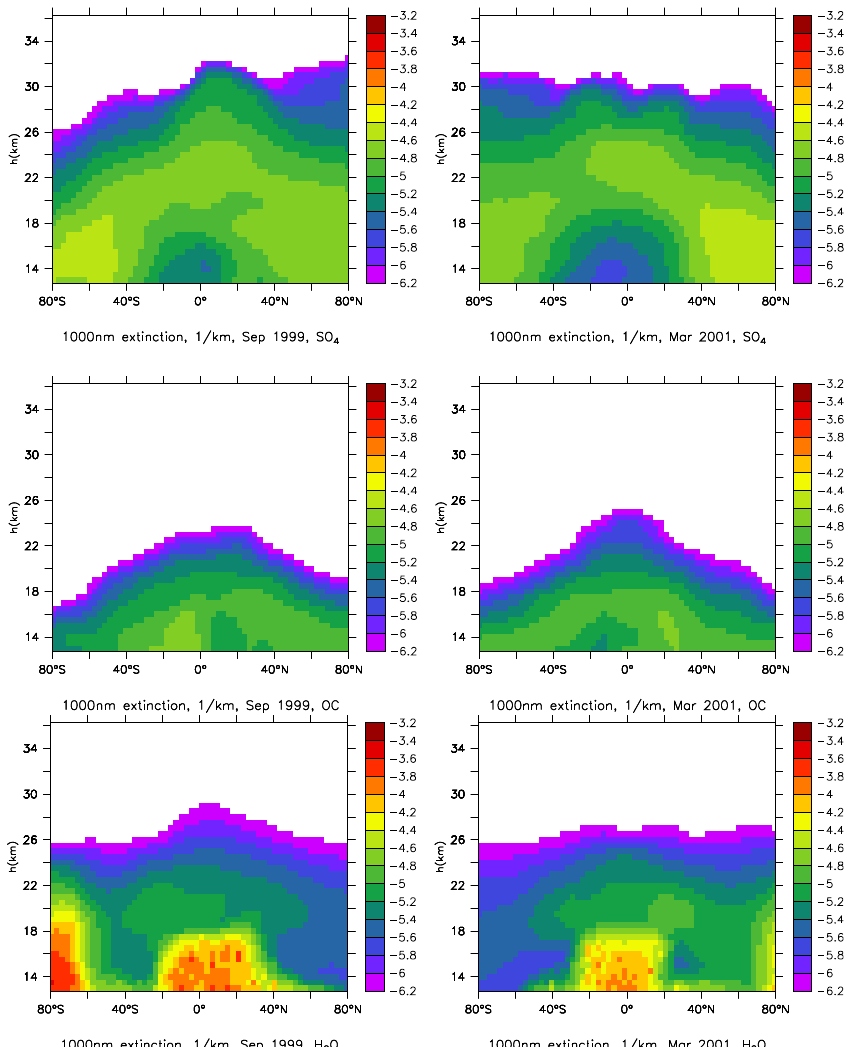
Fig. 8. Contribution of aerosol components to simulated total extinction (Fig. 7). OC is organic carbon.